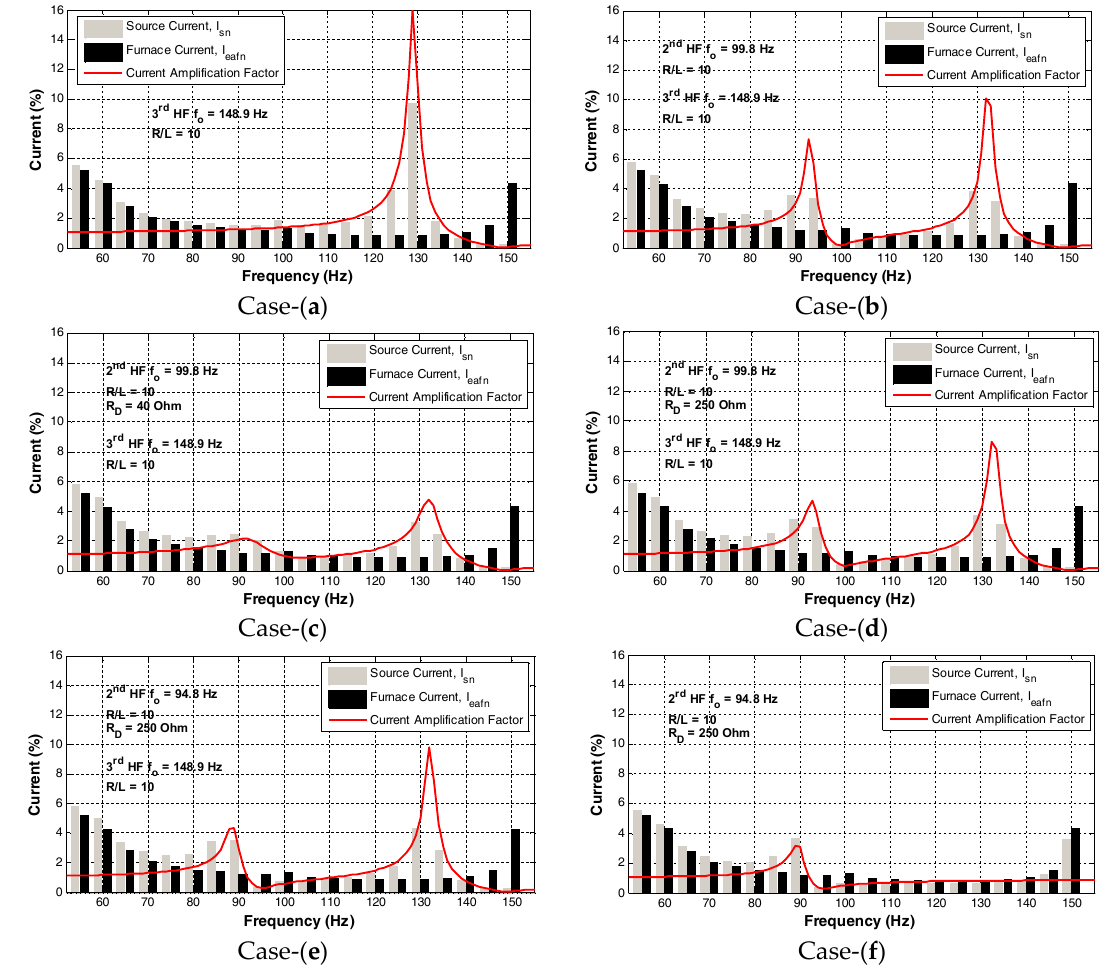
Figure 3. Filtering performances of different passive shunt harmonic filter topologies against harmonics